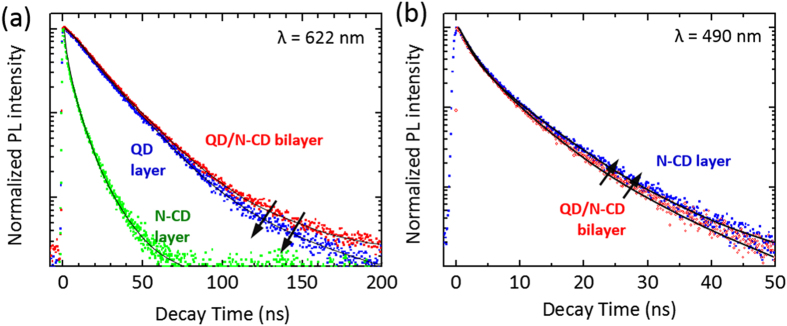
Time-resolved PL spectroscopic analysis.(a) TR-PL spectra of QD/N-CD, QD, and N-CD layers measured at a wavelength of 622 nm. (b) TR-PL spectra of N-CD and QD/N-CD layers measured at 490 nm. The decay curve of QD sole layer was negligible at wavelength of 490 nm. The corresponding fitted curves (black line) were derived from TR-PL data by an iterative deconvolution fitting process based on equation (1) and the instrumental response function. Each amplitude Wi and decay time τi are summarized in Table 1.